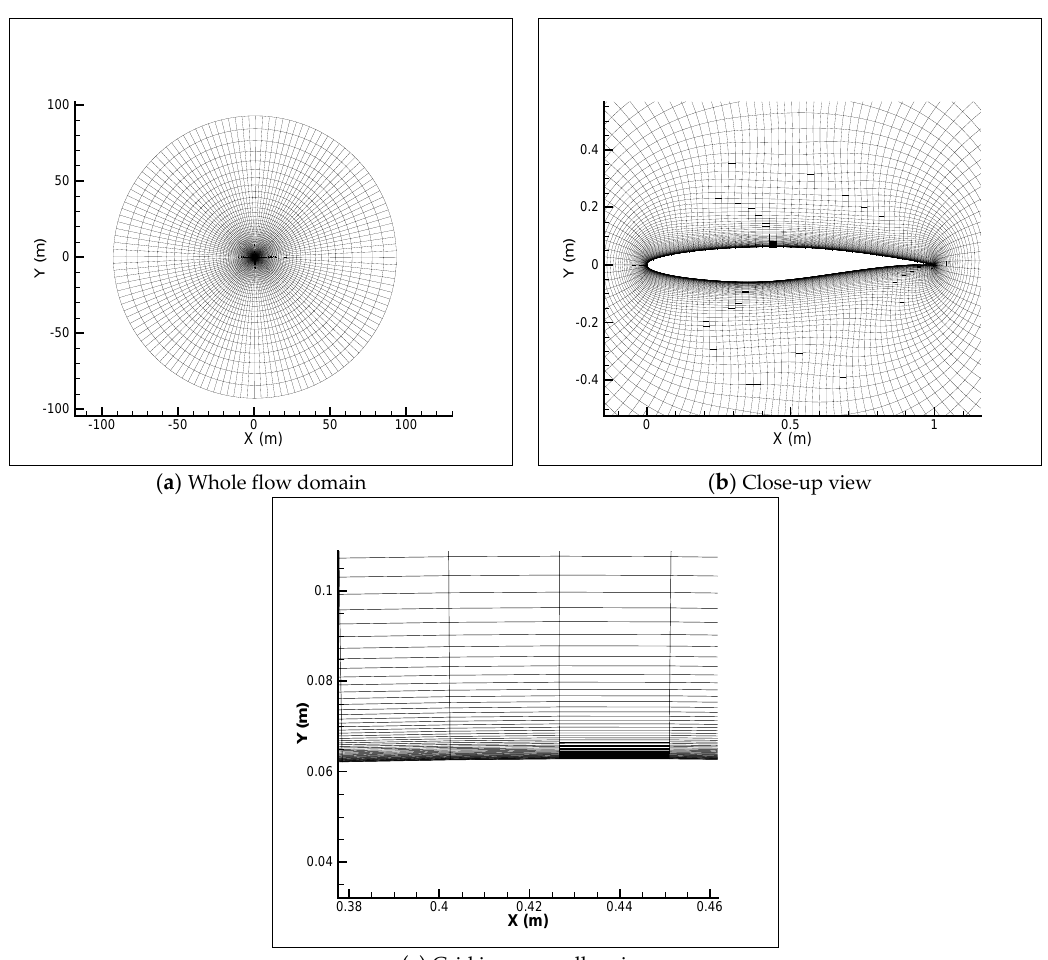
Figure 7. Structured mesh (hyperbolic O-type) around the RAE2822 airfoil used for solving the transonic turbulent flow Equations. The grid size and the wall spacing are 129 × 129 and 5 × 10 − 5 m, respectively.